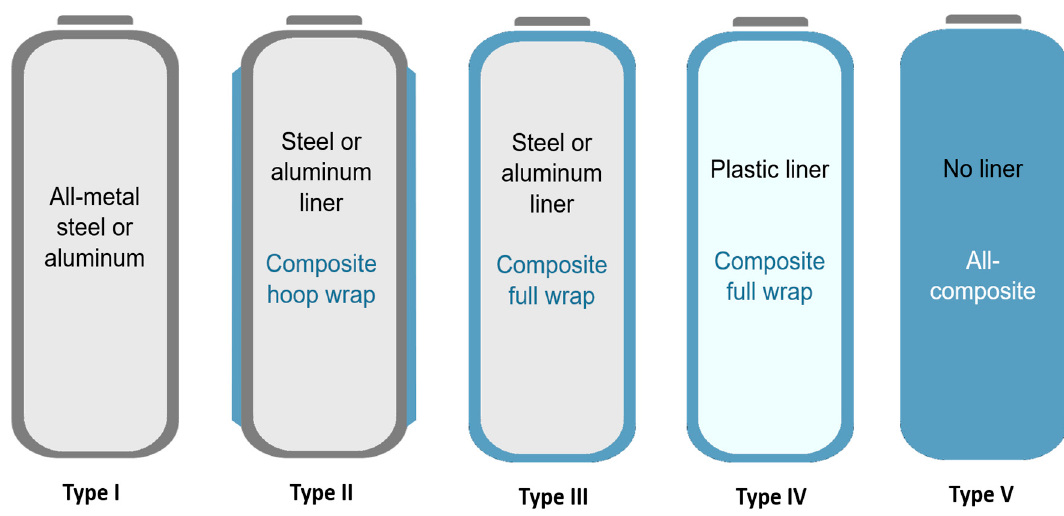
Figure 3. Schematic depiction of the five types of pressure vessels [38].